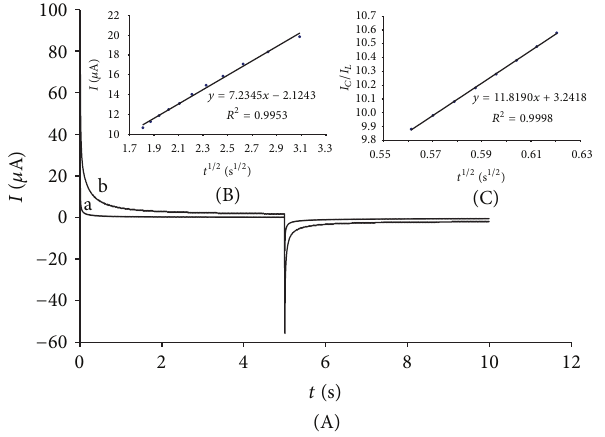
Figure 5: (A) Chronoamperograms obtained at FCAD/NiO/ NPs/CPE (1) in the absence and in the presence of (2) 300.0 𝜇 M cysteamine at pH 7.0. (B) Cottrell’s plot for the data from the chronoamperogram. (C) Dependence of 𝐼 𝑐 /𝐼 𝐿 on the 𝑡 1/2 derived from the chronoamperogram data.